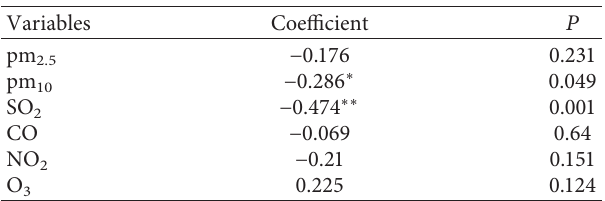
Figure 5: The ACF and PACF graphs of residual sequences of ARMA (1, (1, 3)) model. (a) ACF with 2stds Bounds (i.e., approximate 95% confidence interval). (b) PACF with 2stds Bounds (i.e., approximate 95% confidence interval). Table 4: The results of spearman correlation test between air pollution variables and TB